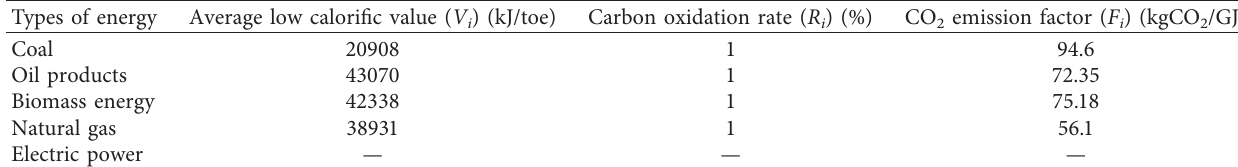
Table 4: Carbon dioxide emissions coefficients of transportation and energy.